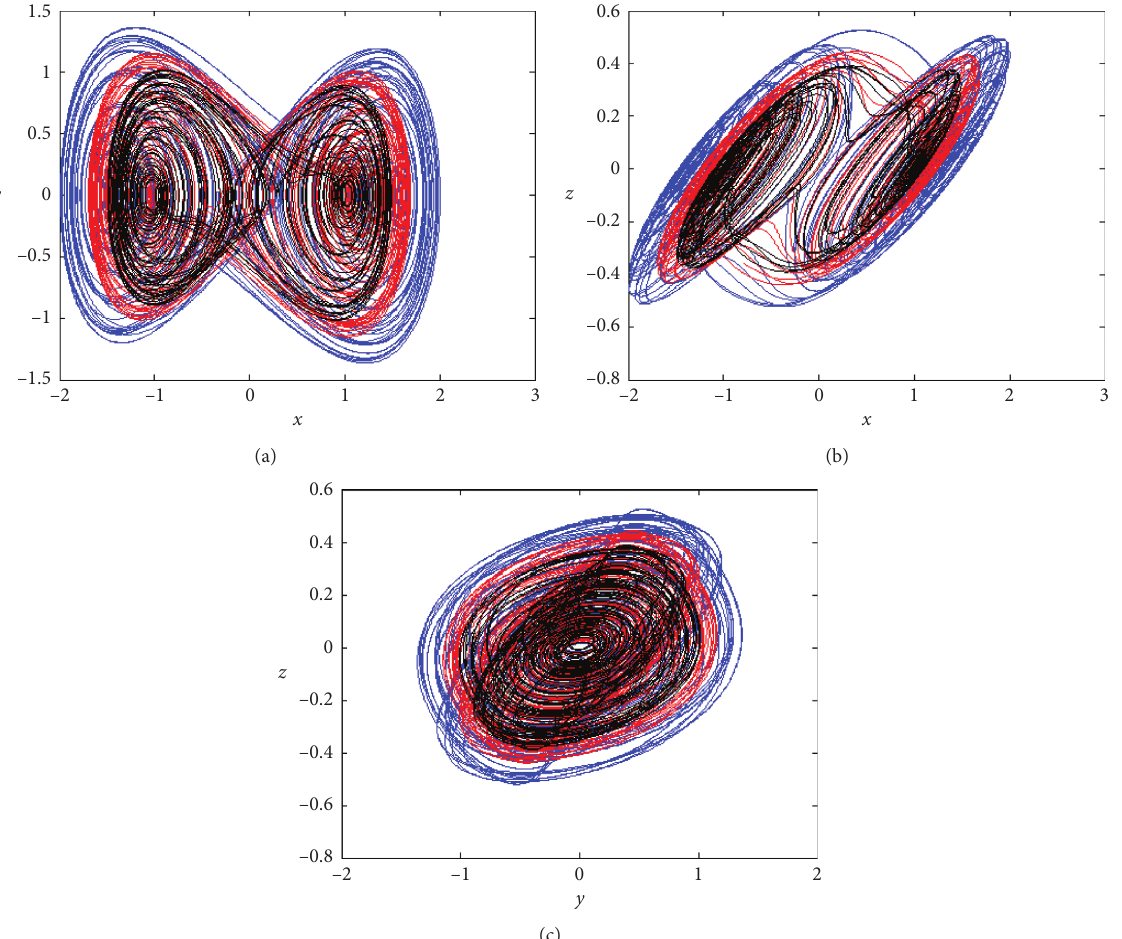
Figure 20: Representation of the amplitude control of the variables, in the phase space, for three different values of the amplitude control parameter: the amplitudes of the curves in blue, red, and black are obtained for 0.5, 0.7, and 0.9, respectively. The other parameters b , w f , k , and m are set to 0.3, 0.5, 1.6, and 0.0,